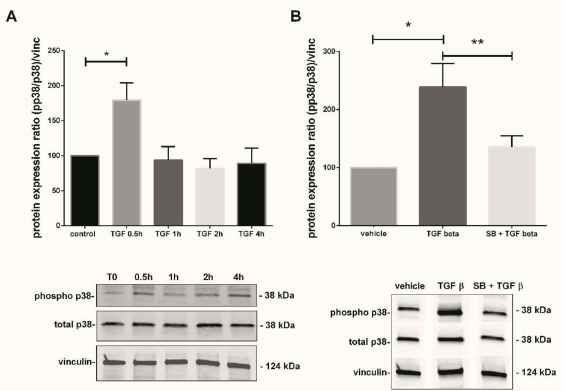
Figure 3. TGF- β 1-mediated activation of p38 MAPK pathway in 7–9 Gestational Weeks (GW) chorionic villi. ( A ) Kinetic of p38 phosphorylation in first trimester chorionic villi exposed to 10 ng/mL of TGF- β 1 for 0.5, 1, 2, or 4 h. Results are expressed as a variation of the ratio of phosphorylated to non-phosphorylated p38 protein expression as compared with time 0 (T0). The results are normalized to vinculin expression. Data are represented as mean +/ − SEM, * p < 0.05, n = 7 different placentas. A one-way ANOVA test was applied. ( B ) Activation of p38 MAPK pathway in first trimester chorionic villi treated with TGF- β 1 (10 ng/mL) for 48 h with or without pretreatment with SB203580 (10 µ M) for 1 h. The protein expression of the phosphorylated p38/total p38 ratio was measured by Western blot. The ratio is significantly increased after 48 h of 10 ng/mL TGF- β 1 treatment as compared with the untreated group and the p38 pretreatment with SB203580 inhibitor abolishes this effect. The protein expression was normalized to vinculin expression and reported to the expression of vehicle control. Data are represented as mean +/ − SEM. * p < 0.05, ** p < 0.01, n = 11 different placentas. RM one-way ANOVA statistical analysis was applied. Control refers to untreated chorionic villi and vehicle refers to DMSO treatment.